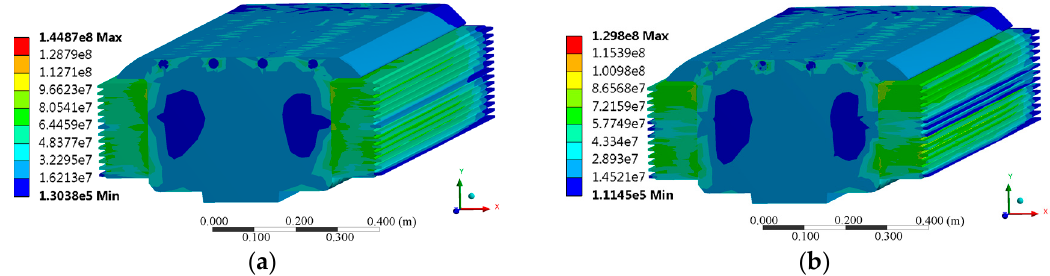
Figure 14. Thermal stress distribution of magnetic pole in short circuit: ( a ) one-turn short circuit; and ( b ) three-turn short circuit.